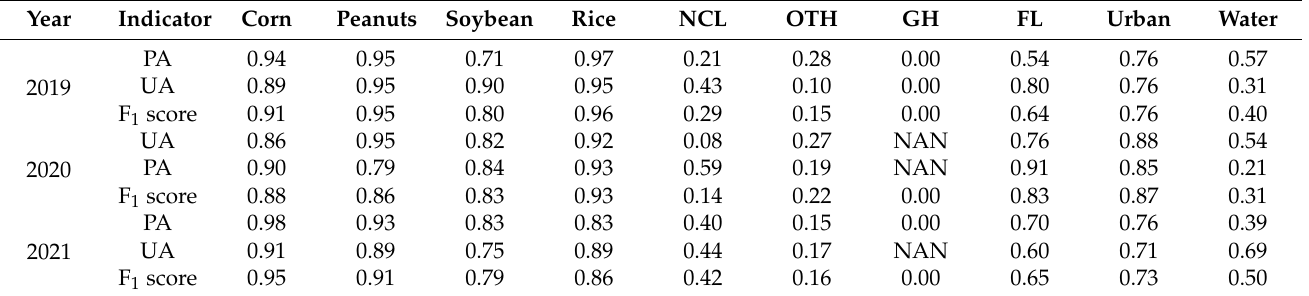
Table 5. PA, UA, and F 1 score from scheme 2 and the UNet++ model. The abbreviation NaN represents not-a-number due to the zero denominator.